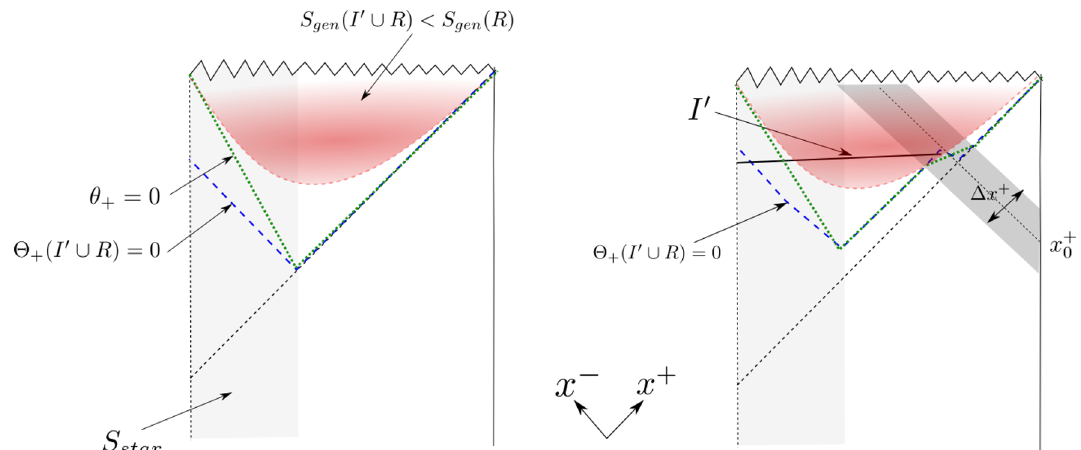
Figure 7 : Left: a large, isolated AdS black hole formed from a collapsing star. The star is in a mixed state of entropy S that is purified by R in an auxiliary non-gravitating star spacetime. Spherical symmetry is assumed, and I 0 are ball regions whose boundaries are points in the figure. To be an island mirage I 0 ∪ R must be both outside the quantum apparent horizon, depicted in blue, and the inside the red hyperentropic region. Right: a null shell of pure radiation is added. The null shell has a large entropy gradient in the x + direction, so as to push the quantum apparent horizon into the red hyperentropic